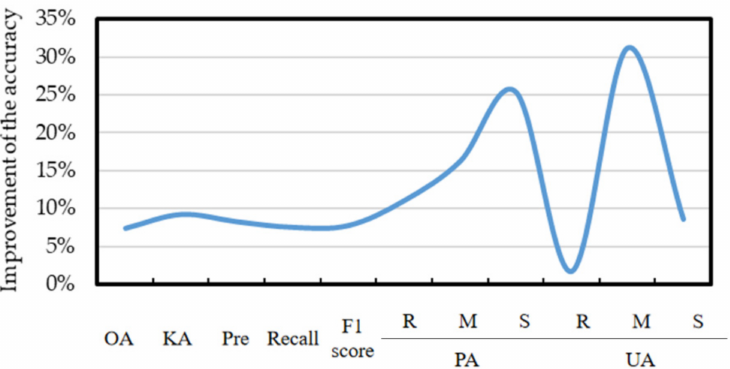
Figure 8. Results of the classification based on IO-Growth model with ( a ) pixel-based method, ( b ) object-oriented method.